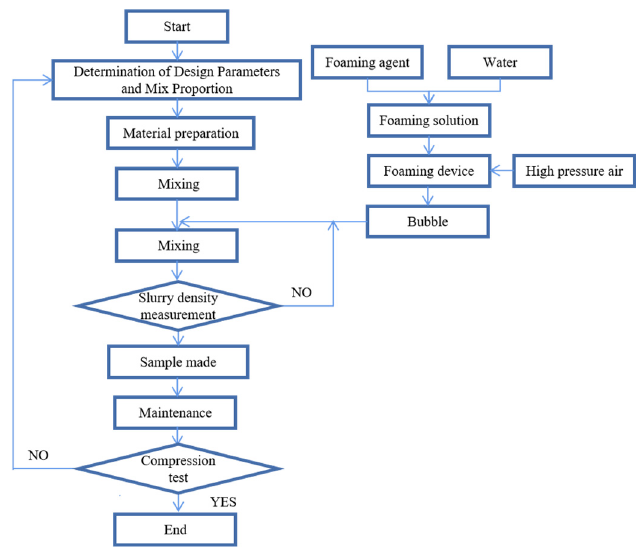
Figure 2. The work process of preparing foam concrete.